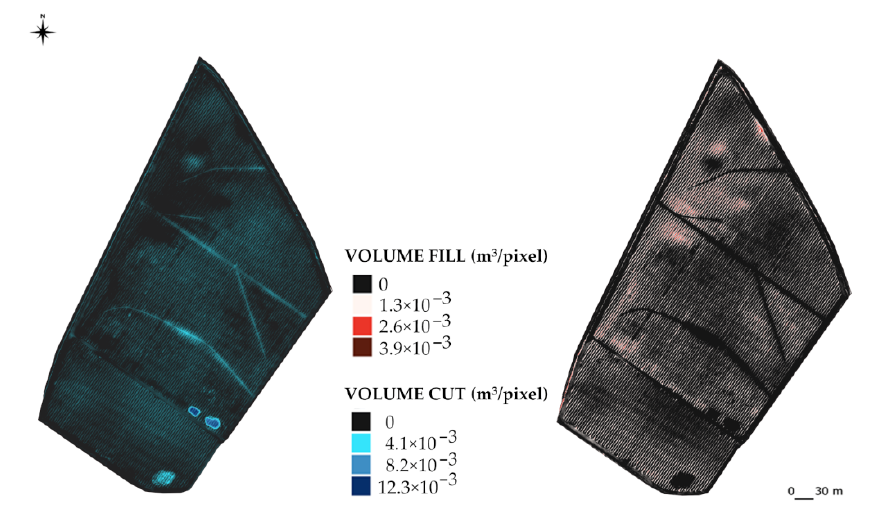
Figure 18. Volume change (m 3 per pixel) obtained from the multiplication of the pixel area (0.49 cm 2 ) by elevation difference value.